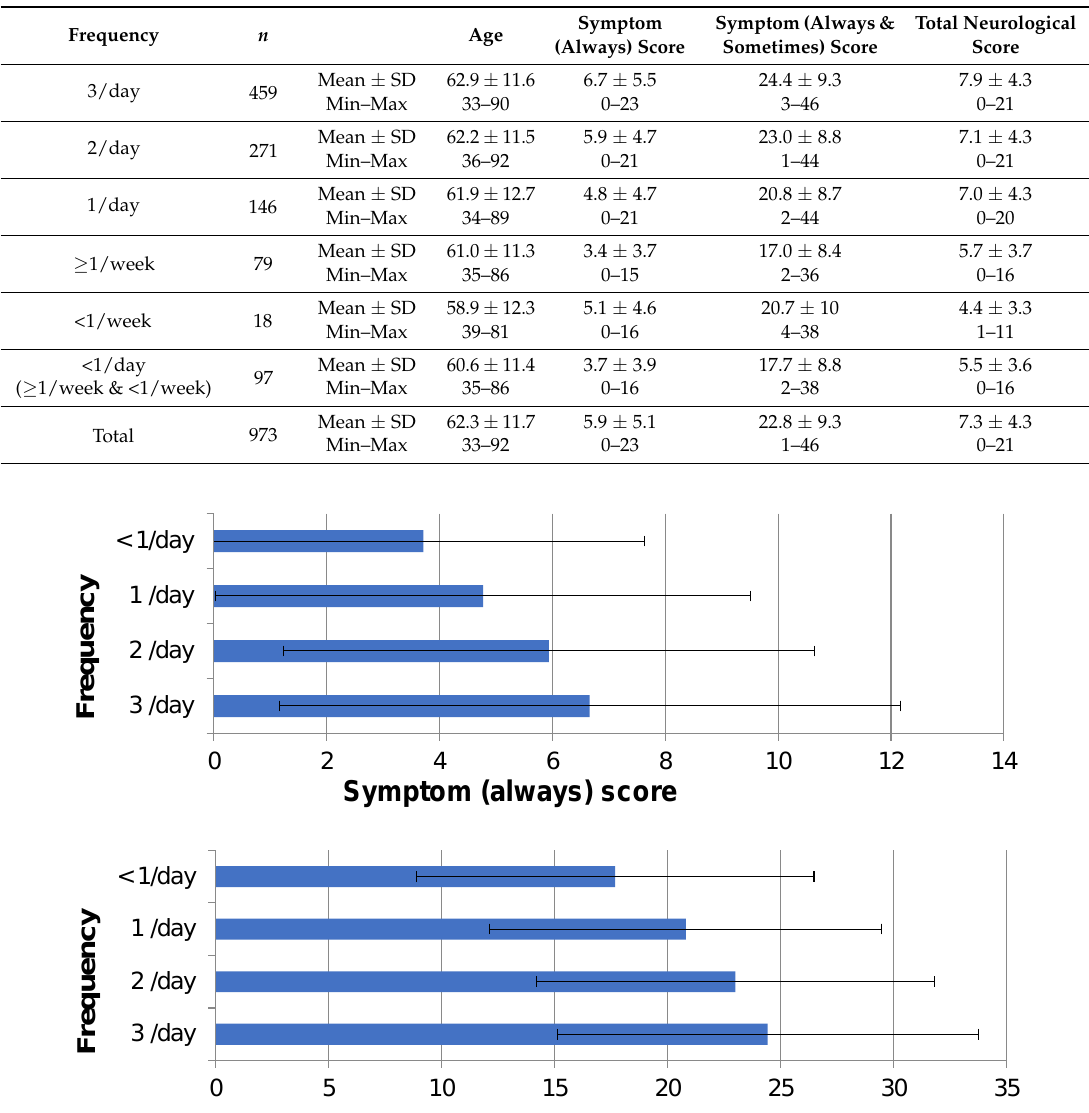
Table 11. Frequency of fish ingestion and scores ( n = 973).